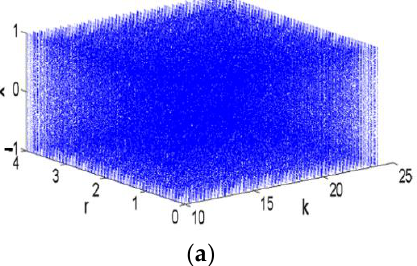
Figure 4. Dynamical behavior of CLM: ( a ) bifurcation plot; ( b ) Lyapunov exponent.